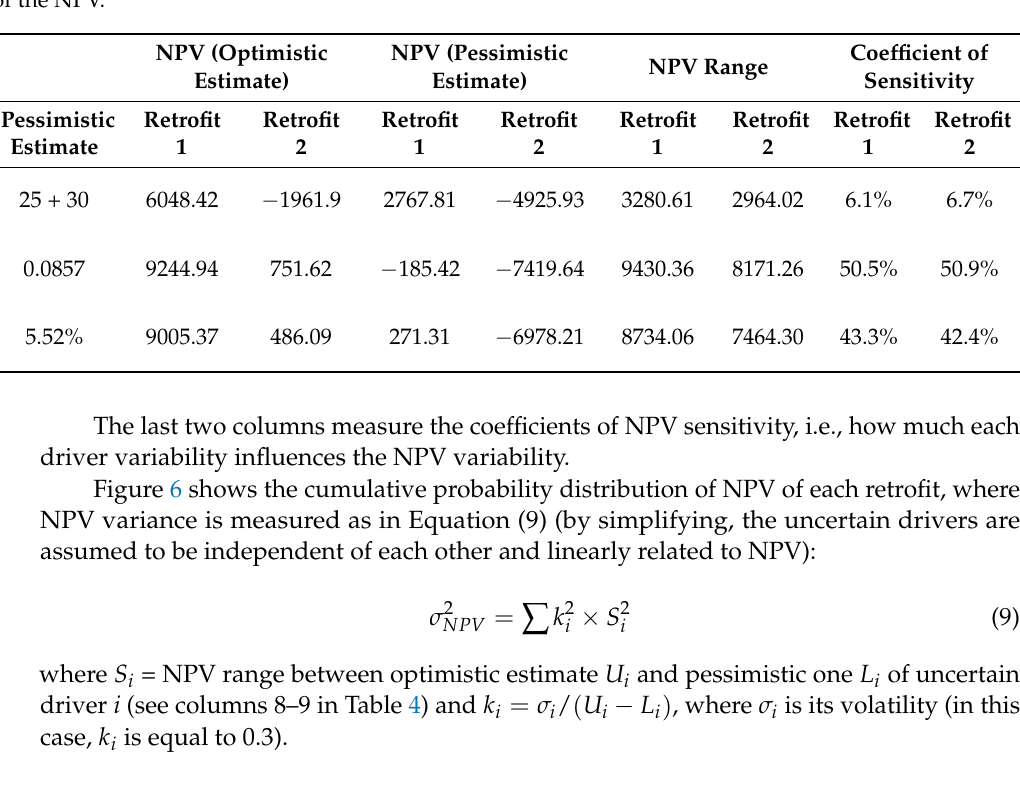
Table 4. Sensitivity analysis of the NPV.